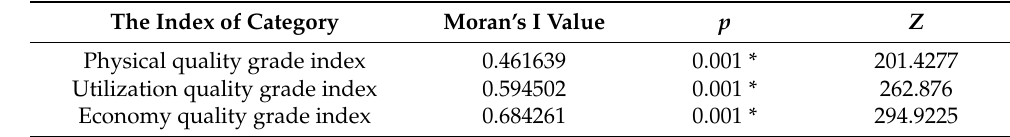
Table 3. Moran’s I value of global spatial auto-correlation analysis of cultivated land quality at county level in Pengshui County.